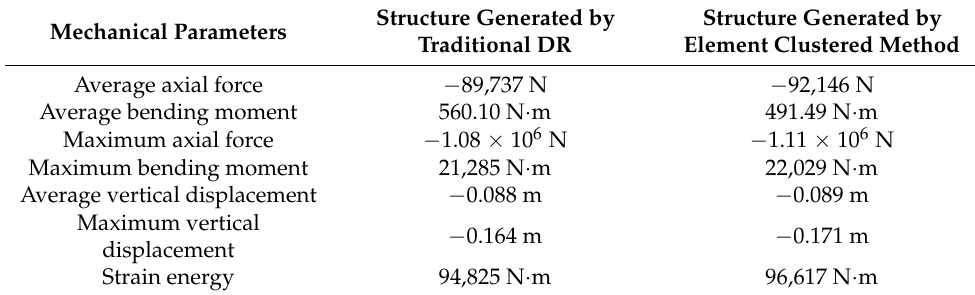
Table 2. Mechanical properties of the generated